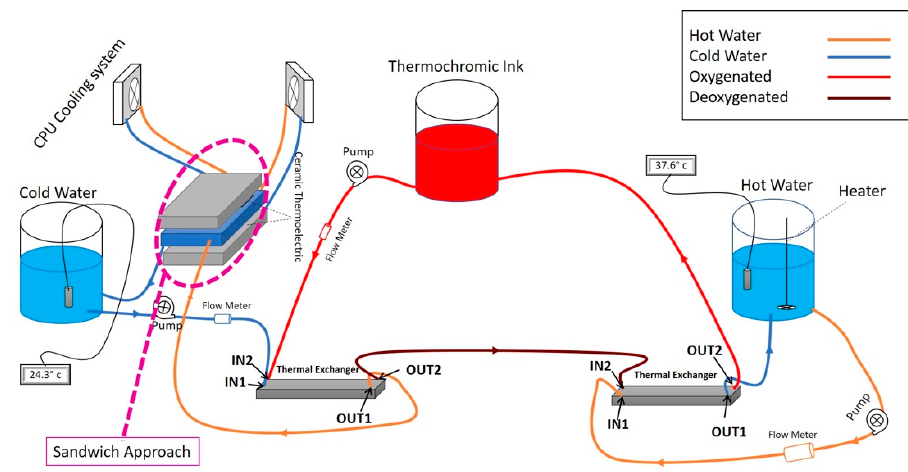
Figure 2. Overview of the heater–cooler prototype.